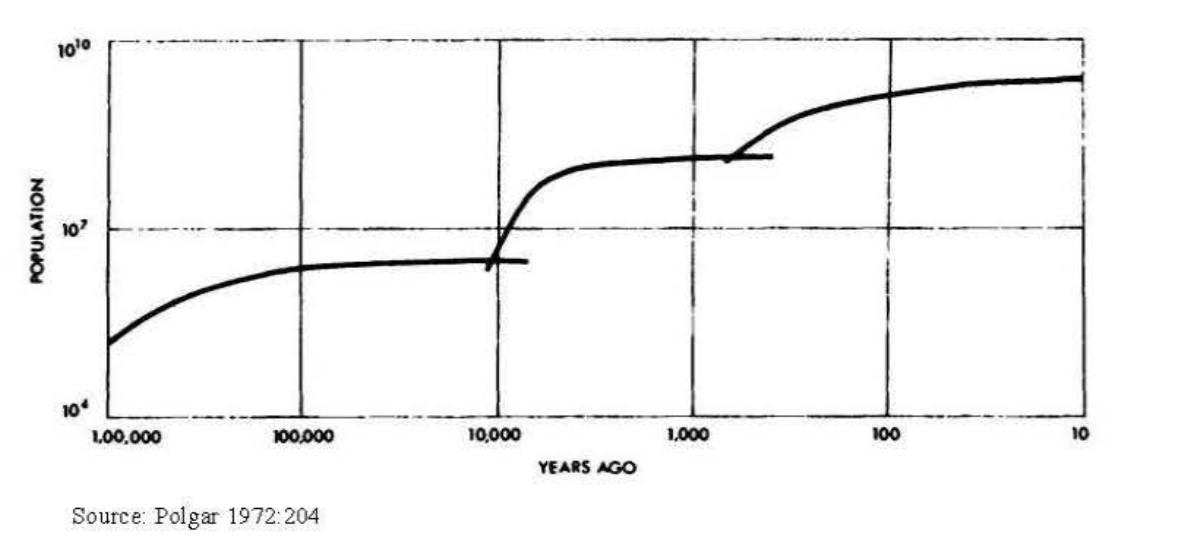
Figure 1. Logarithmic population